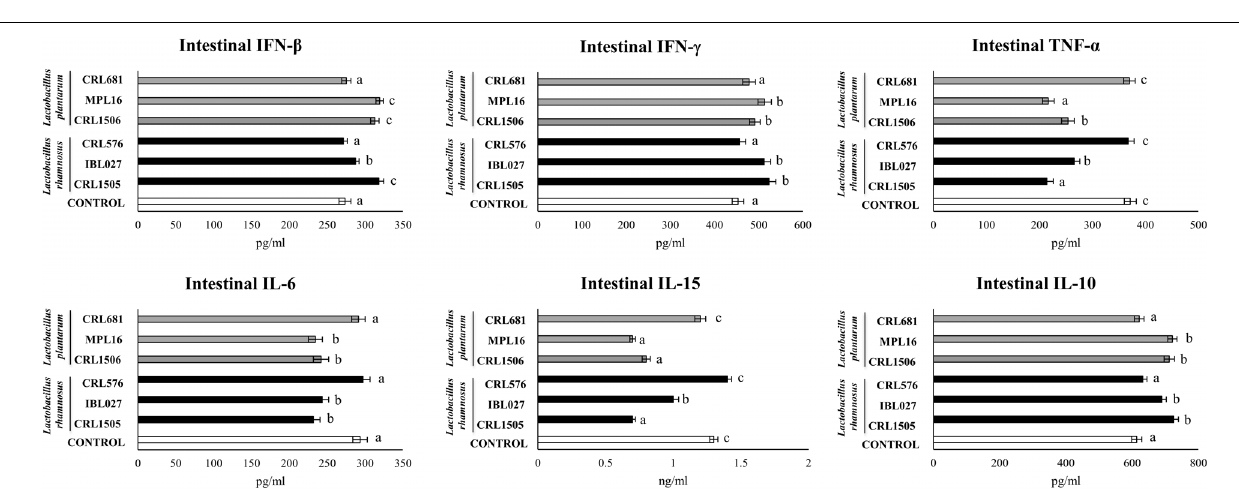
FIGURE 4 | Levels of serum injury markers [lactate dehydrogenase (LDH) and aspartate aminotransferase (AST)] in mice orally treated with Lactobacillus rhamnosus CRL1505, L. rhamnosus IBL027, L. rhamnosus CRL576, Lactobacillus plantarum CRL1506, L. plantarum MPL16, or L. plantarum CRL681 (10 8 cells/mouse per day for five consecutive days) and then challenged by the intraperitoneal route with 30 µ g of the viral molecular–associated pattern poly(I:C). Mice with no lactobacilli treatment and challenged with poly(I:C) were used as controls. Serum injury markers were evaluated on day 2 after poly(:C) administration. The results represent data from three independent experiments ( n = 6 per group). Letters indicate significant differences ( P < 0.05), a < b < c.